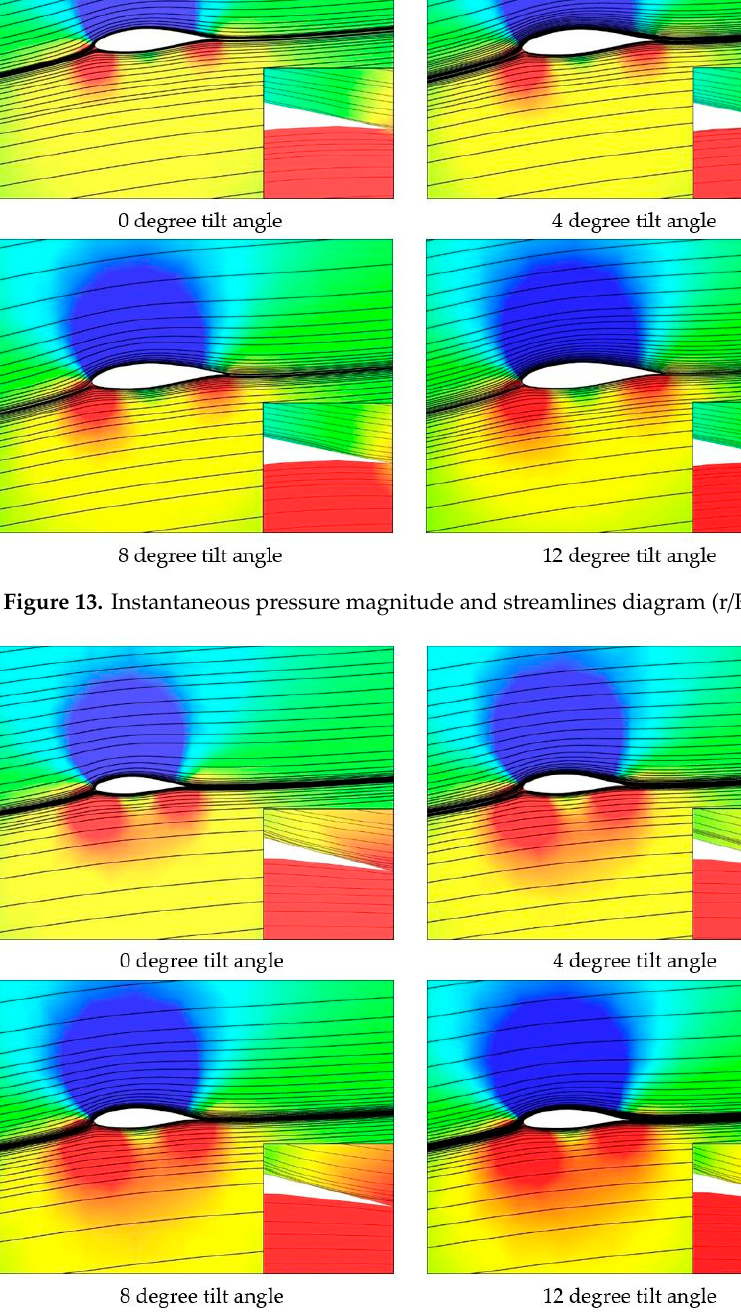
Figure 14. Instantaneous pressure magnitude and streamlines diagram (r/R = 0.9).